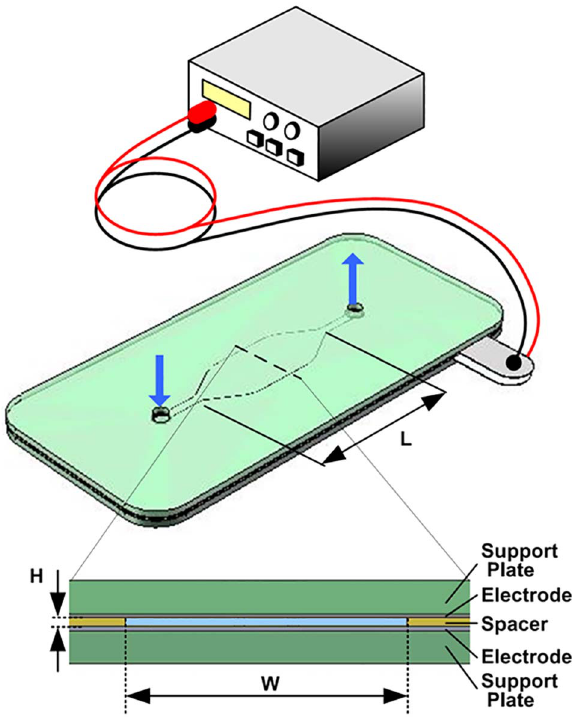
Figure 2. The schematic view of the flow-through electrical lysis device. A microfluidic chamber was fabricated by bonding the electrodes to two flat Lexan plates and then sandwiching a dielectric spacer element between the electrodes. The electronic system supplies bipolar square electric pulses whose amplitude or frequency can be controlled in response to chamber temperature obtained in real-time from chamber conductivity measurements.